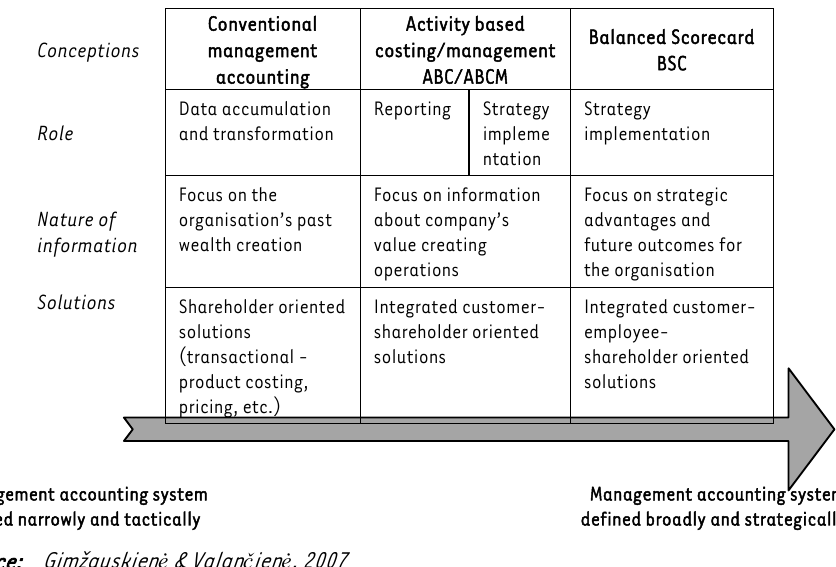
FIGURE 1: Changing role of management accounting